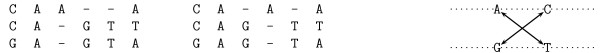
Alignments and homology structure. (Left:) Two alignments representing the same homology structure. A "homology structure" is defined as the set of all homology relationships between residues from the given sequences; residues are homologous if they appear in the same alignment column. Our recursion includes contributions from all alignments compatible with a given homology structure (itself represented by a single alignment). (Right:) Due to the evolutionary process acting on the sequences, homology relationships (arrows) will never 'cross' as depicted. This restriction on the equivalence relation ~ is codified by <h (see text).